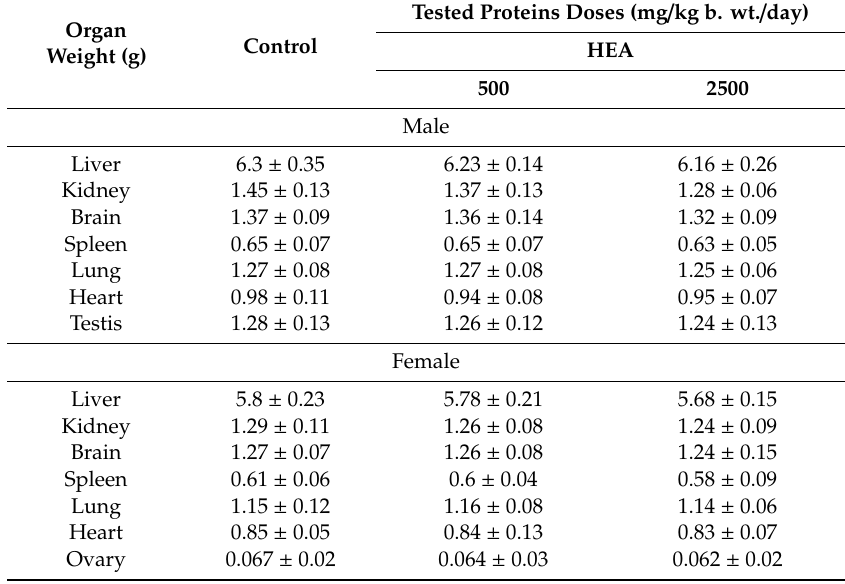
Table 5. E ff ect of hydrolyzed egg albumin (HEA) on organ weight (g) of male and female albino rats treated orally daily for 28